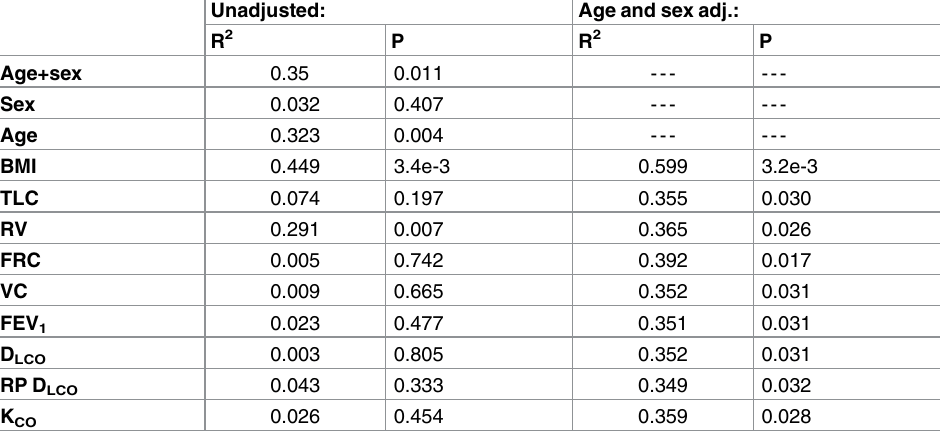
Abbreviations: body mass index, total lung capacity, residual volume, functional residual capacity, vital capacity, forced expiratory volume in 1 second, diffusing capacity of the lung for carbon monoxide (D L,CO ), relative predicted D L,CO and D L,CO corrected for alveolar volume